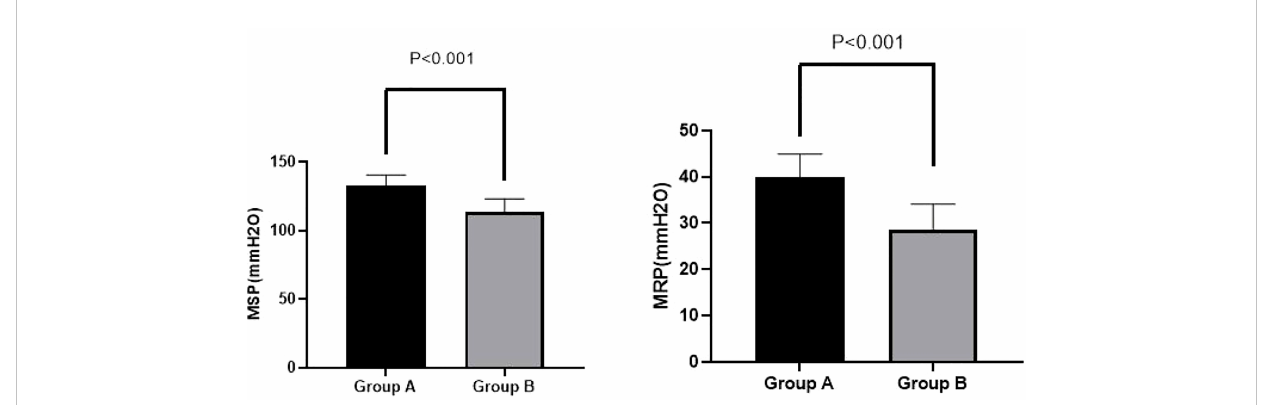
FIGURE 2 MSP and MRP in Groups A and B at week 4. A signi fi cant improvement in MRP (39.93 ± 5.02 vs. 28.70 ± 5.40 mmH 2 O, p < 0.001) and MSP (132.43 ± 8.16 vs. 113.33 ± 9.87 mmH